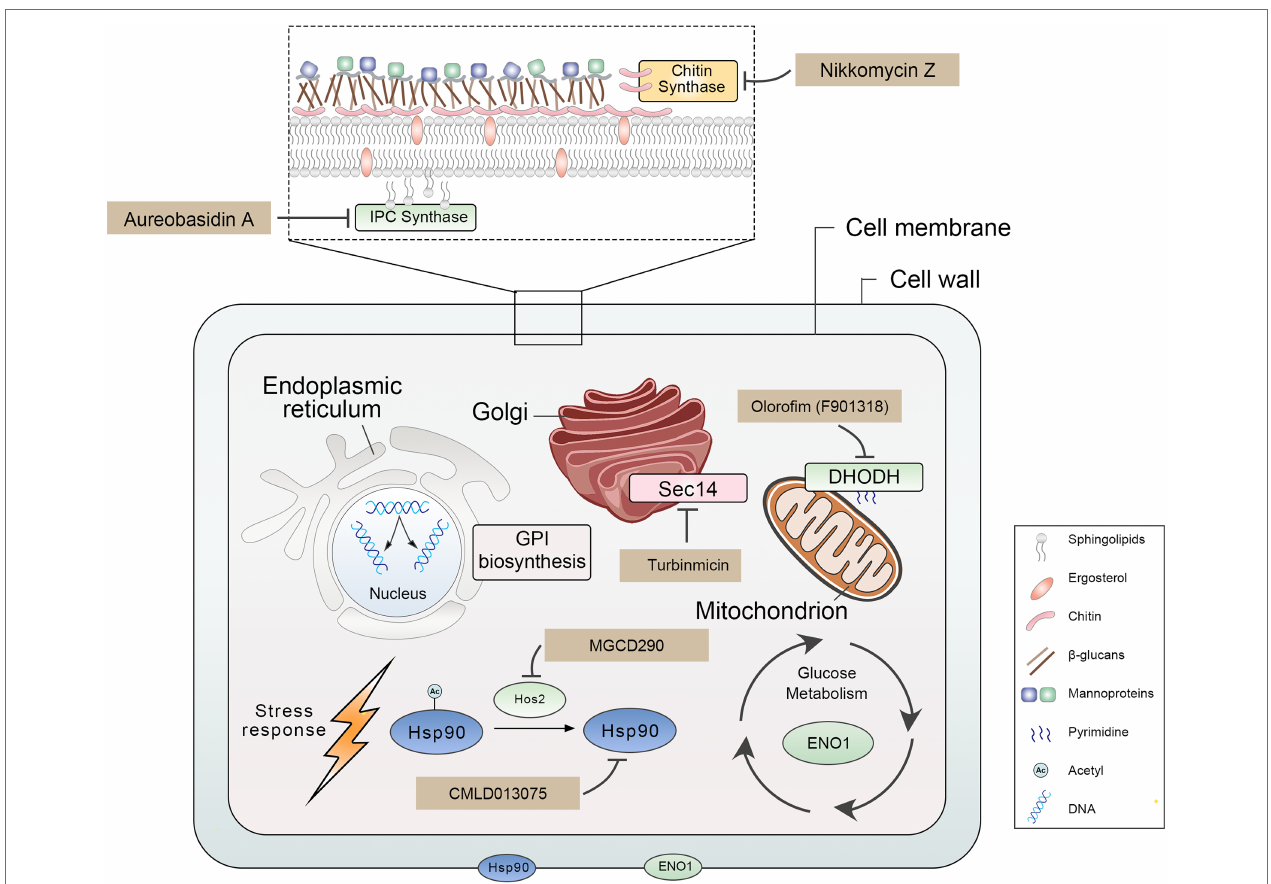
FIGURE 1 | Overview of antifungal target proteins and their